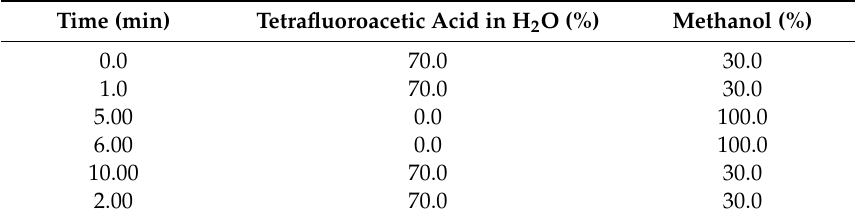
Table 3. The mobile phase (0.1% tetrafluoroacetic acid in H 2 O: methanol)